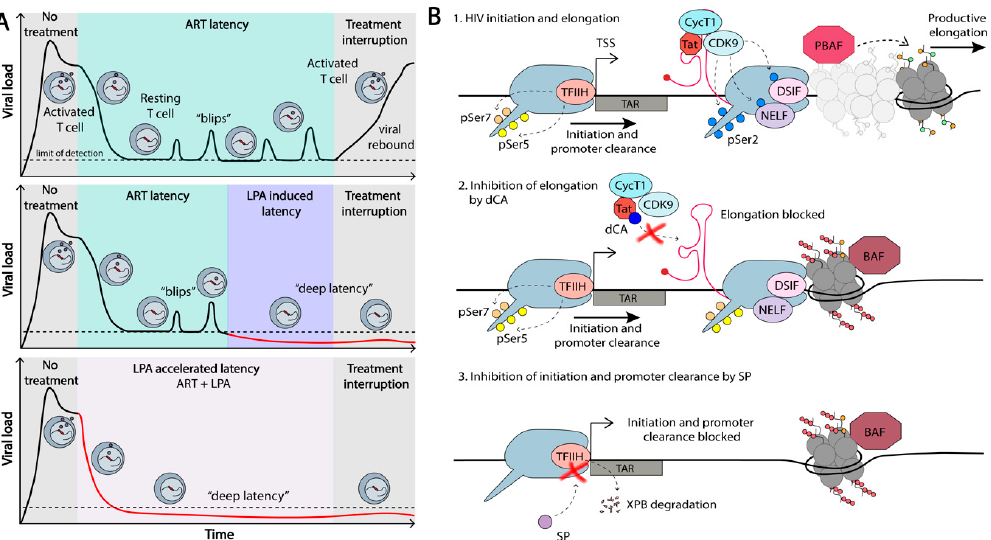
Figure 6. Block-and-lock approach for a functional HIV-1 cure. ( A ) Top panel : Upon HIV-1 infection, within a few weeks, there is a peak of viral load (VL) circulating in the plasma of infected individuals. Upon ART initiation, the VL drops to below the limit of detection (50 viral copies/ml), termed “ART latency”. VL “blips,” or episodes of detectable viremia, and are observed in many individuals under ART. Upon discontinuation of ART, there is a rapid rebound of VL to pre ‐ ART levels. Middle panel : The addition of a latency promoting agent (LPA), such as the Tat inhibitor dCA, to an ART regimen could suppress the ongoing transcriptional events, induce epigenetic silencing over time, and promote a state of “deep latency”. This might allow for safe ART discontinuation either without viral rebound, or a sufficiently low rebound, such that the immune system is able to control and suppress it. Bottom panel : The addition of an LPA at the initiation of ART might accelerate entry into latency, reduce transcriptional events, and potentially limit the size of the reservoir through a reduction in the total number of infected cells. The state of “deep latency” could be achieved earlier, reducing the amount of chronic immune activation in infected individuals and perhaps accelerating the epigenetic silencing of the provirus. ( B ) 1. When an HIV ‐ 1 infected CD4 + T cell is activated, recruitment of the host TFs and RNAPII allows for efficient PIC formation, initiation of transcription, promoter escape, and some readthrough transcription to produce full length viral transcripts and, thus, Tat. A positive feedback loop is established, where Tat promotes productive elongation through recruitment of P ‐ TEFb and the chromatin remodeler, PBAF. 2. The Tat inhibitor dCA binds to the basic domain of Tat and blocks Tat interaction with TAR RNA, blocking recruitment of P ‐ TEFb directly to the HIV ‐ 1 promoter. Thus, transcriptional elongation is inhibited, and a more repressive chromatin environment can form at the promoter. 3. The small molecule SP causes degradation of the XPB subunit of TFIIH, which has been shown to inhibit transcription and reduce RNAPII occupancy at both the promoter as well as along the entire genome. SP provides another tool to explore the block ‐ and ‐ lock approach for a functional cure.